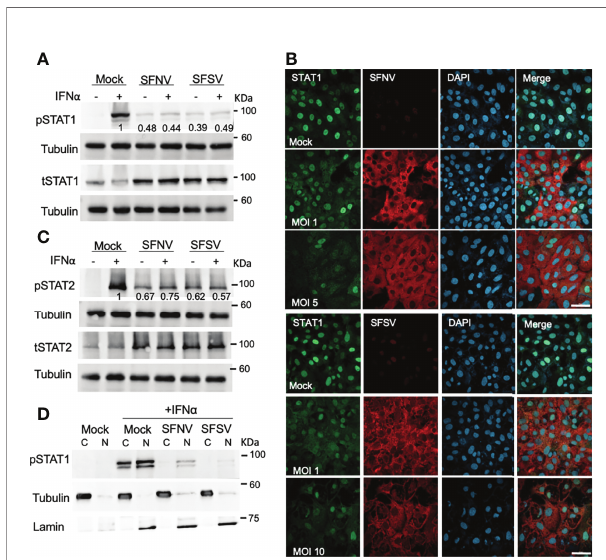
FIGURE 2 | Sand fl y virus infection decreases the phosphorylation of STAT1 and 2. (A) SFNV, and SFSV inhibits STAT1 phosphorylation. A549 cells were infected with SFSV or SFNV at an MOI of 1. The cells were stimulated with IFN a (1000 U/ml) for 30 min 24 h post-infection. The lysates were analyzed by western blot using speci fi c antibodies for phosphorylated or total STAT1. Tubulin was used as a loading control. Numbers below the bands represent average bands intensity from three independent experiments quanti fi ed using ImageJ and are expressed as a percent of mock-infected and stimulated control. (B) SFNV and SFSV affect STAT1 localization. Vero cells were infected with SFNV at the indicated MOIs (left). The next day, cells were treated with IFN a (1000 U/ml) for 30 min, then fi xed and co-stained with anti-Naples (red) and anti-STAT1 (green) speci fi c antibodies. DAPI was used for nuclei labeling (blue). A similar experiment was performed following SFSV infection. Staining was with anti-Sicily antibodies (right). Scale bar=50µM. (C) SFNV and SFSV infection inhibit STAT2 phosphorylation. Cells were infected and stimulated and analyzed as described above for STAT1. Analysis was performed using STAT2 and phospho-STAT2 speci fi c antibodies. (D) Subcellular fractionation of Infected cells. A549 cells were infected with SFSV or SFNV at an MOI of 1. The cells were stimulated with IFN a (1000 U/ml) for 30 min 24 h post-infection. The cells were fractionated, and the lysates were analyzed by western blot